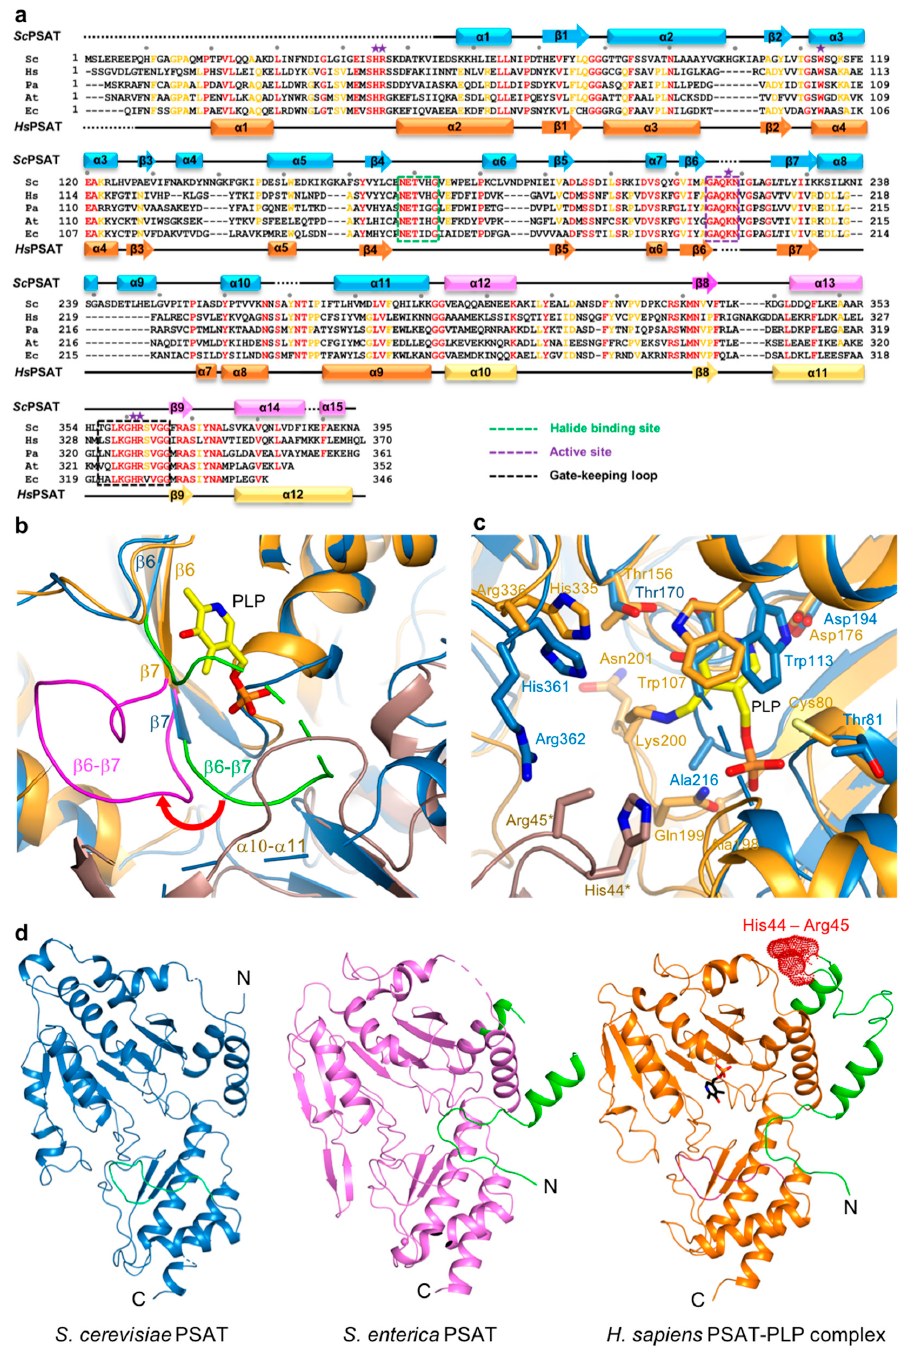
Figure 3. Active site of Sc PSAT. ( a ) Sequence alignment of Sc PSAT (KAF4004669.1), Hs PSAT (NP_478059.1), Pa PSAT (WP_003106701.1), At PSAT (NP_195288.1), and E. coli PSAT ( Ec PSAT; WP_000057138.1). Secondary small domain (pink) and large domain (cyan) structural elements of Sc PSAT are presented on the top. Conserved residues with 100% identity among the indicated species are highlighted in red. Conserved residues with 80% identity are colored in orange. Purple stars above the sequences indicate residues involved in the catalytic reaction. Black dots above the sequences indicate every tenth residue. Active site, gate-keeping loop, and halide-binding site are marked by black-dotted squares. ( b ) Schematic drawing of the overlaid active site of Sc PSAT (blue) and Hs PSAT (orange). A neighboring molecule of Hs PSAT is shown in brown color. Pyridoxal-5- phosphate (PLP) is colored yellow. The β 6– β 7 loops of Sc PSAT and Hs PSAT are highlighted by